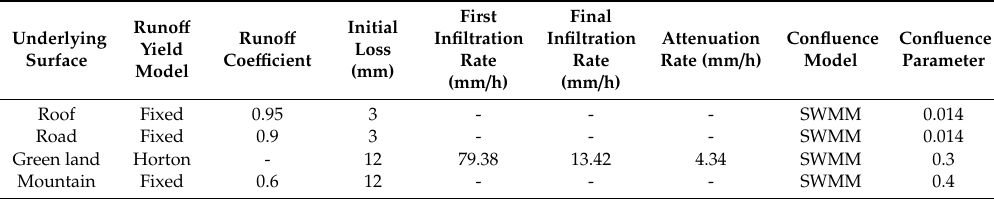
Table 1. Parameters of the production confluence